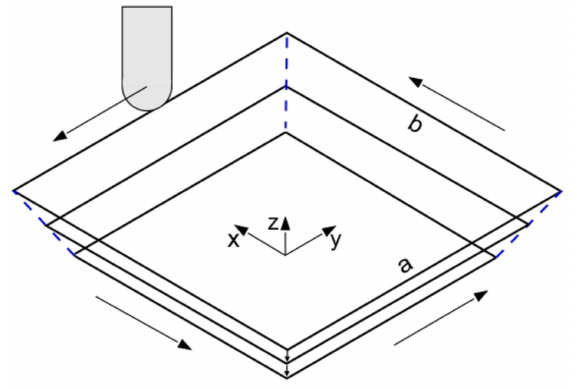
Figure 31. Sides of the tool path during the forming of pyramid frusta.